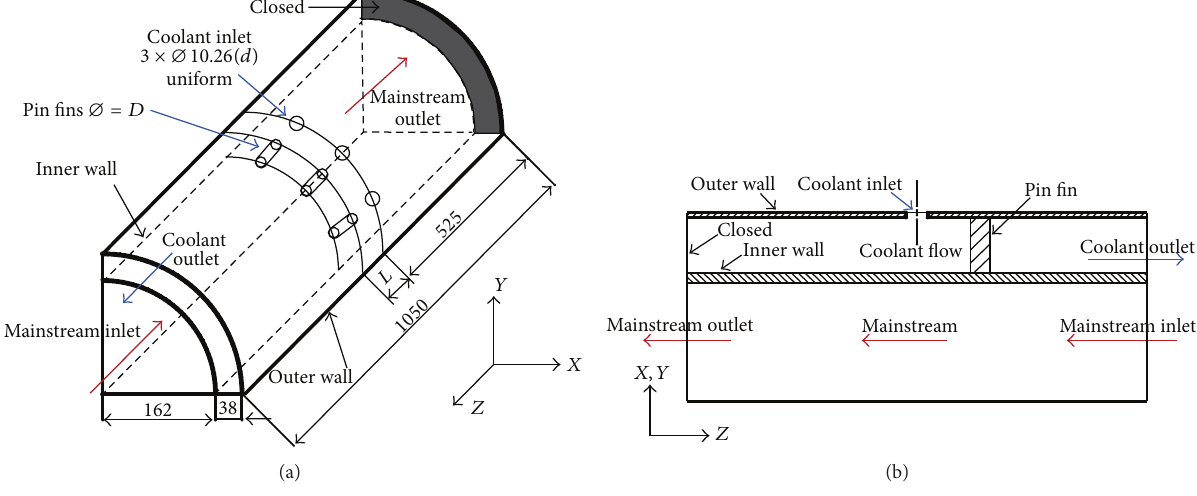
Figure 1: Computational domain showing boundary